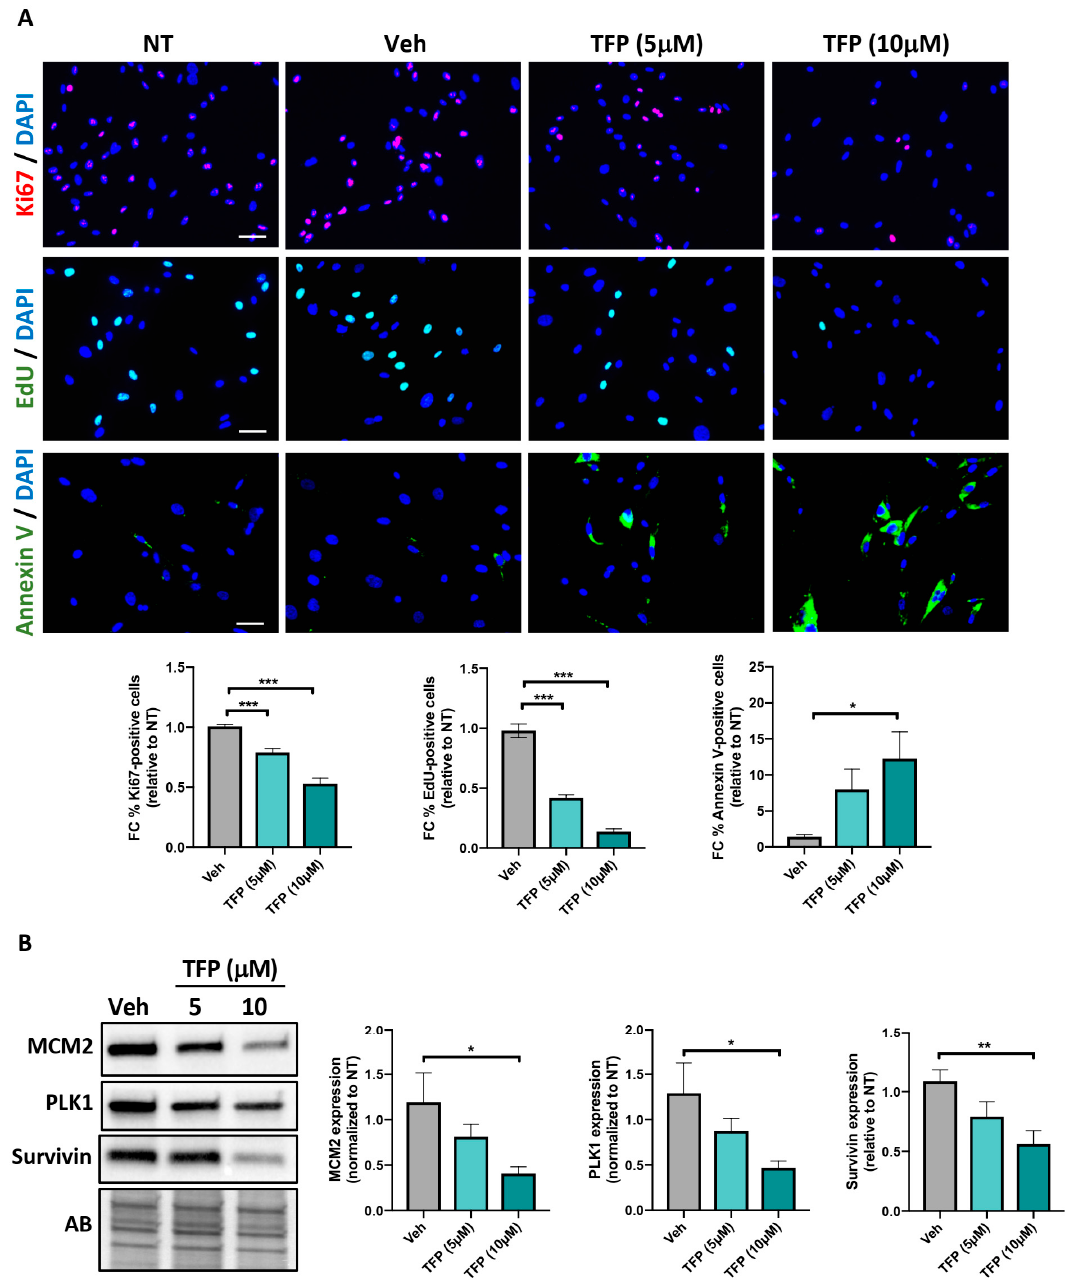
Figure 1 Figure 1. Trifluoperazine (TFP) elicits anti-proliferative and anti-pro-survival effects on pulmonary arterial hypertension pulmonary artery smooth muscle cells (PAH-PASMCs). ( A ) Proliferation (Ki67 and 5-Ethynyl-2 (cid:48) -deoxyuridine (EdU)) and apoptosis (Annexin V) were measured in PAH-PASMCs after treatment or not with TFP or its vehicle (Veh, DMSO) for 24 h. Representative immunofluorescence images of Ki67-, EdU- and Annexin V-positive cells as well as corresponding quantifications are shown. ( B ) Representative Western blots and corresponding densitometric analyses of mini chromosome maintenance protein 2 (MCM2), polo-like kinase 1 (PLK1) and Survivin in PAH-PASMCs exposed or not to the indicated concentration of TFP or its vehicle for 24 h. Data are expressed as fold change (FC) relative to untreated cells and presented as mean ± SEM. Protein expression was normalized to Amido black (AB). Experiments were performed in triplicate in at least four different PAH-PASMC cell lines. * p < 0.05; ** p < 0.01 and *** p < 0.001. Scale bars: 50 µ